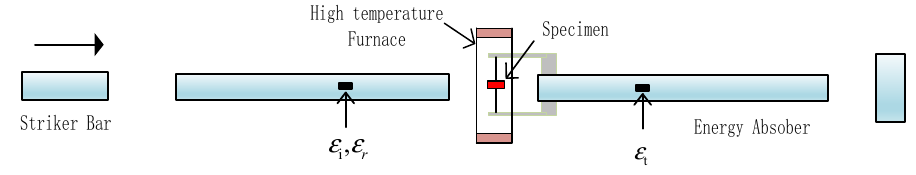
Figure 6. High temperature furnace used for the Hopkinson bar test.